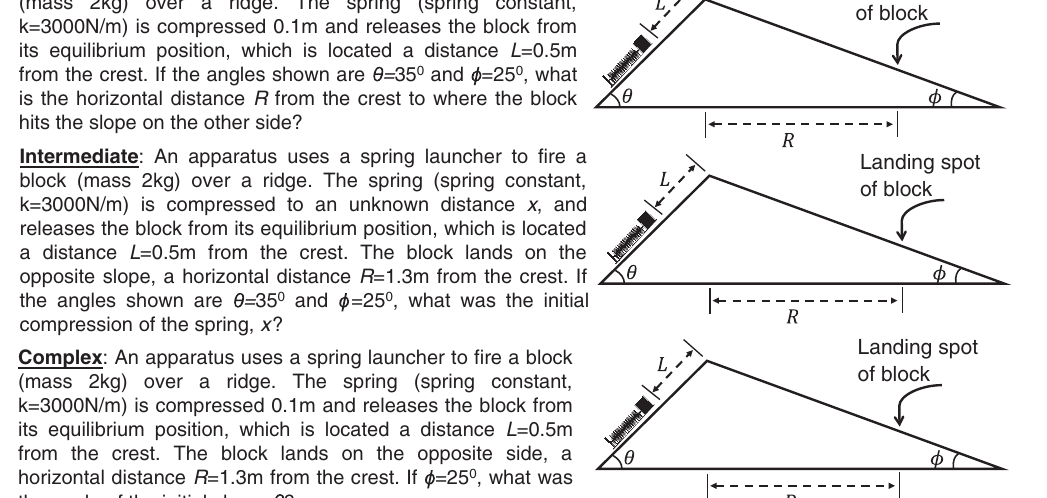
FIG. 2. The three versions of the sequential synthesis